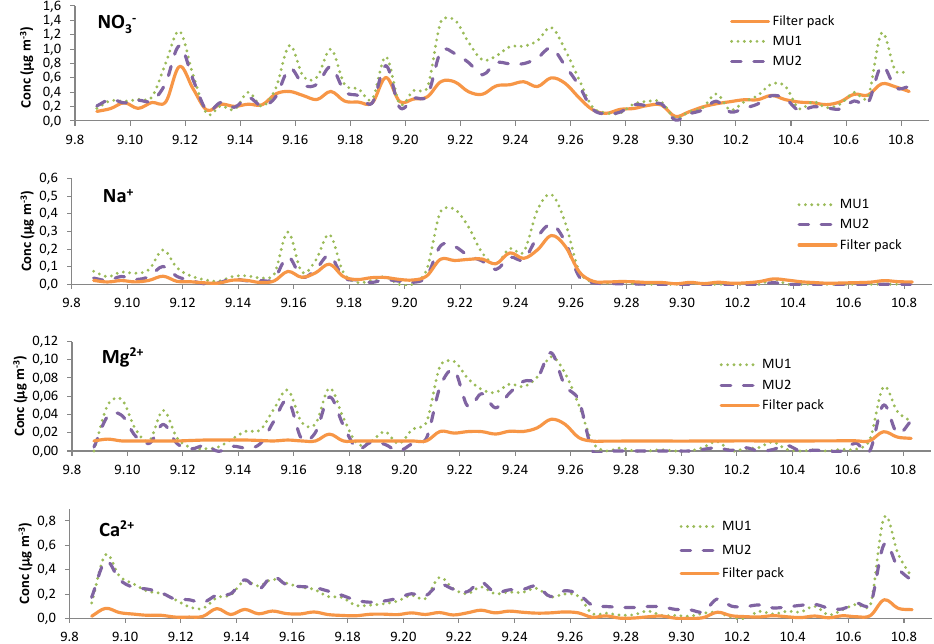
Fig. 8. Concentration trends of NO 3- and 3 compounds (Na + , Mg 2+ , Ca 2+ ) that are often components of the coarse NO 3- aerosol. 5 Figure 8. Concentration trends of NO − and 3 compounds (Na + , Mg 2 + , Ca 2 + ) that are often components of the coarse NO − 3